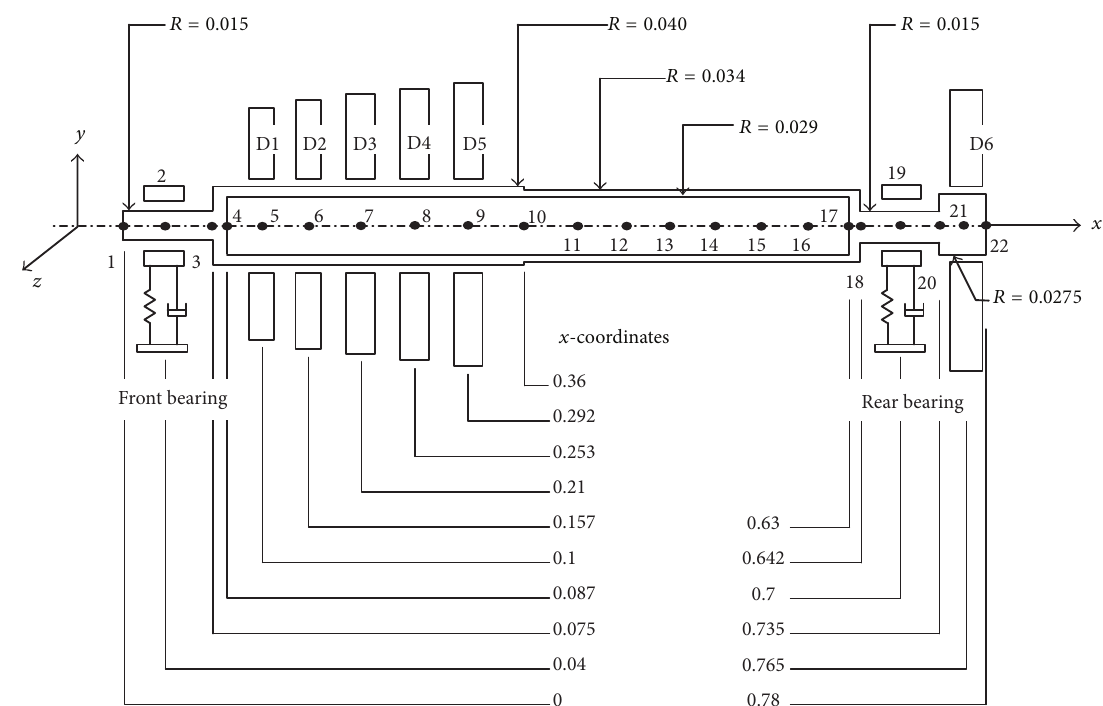
Figure 4: Rotor-bearing system for the FE analysis of the developed gas turbine with its primary nodes. All dimensions are in